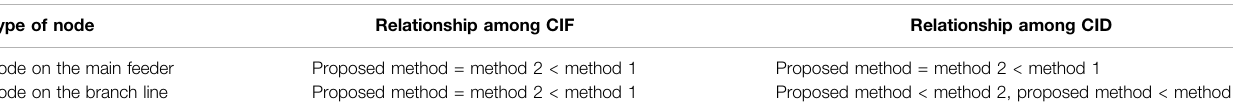
TABLE 8 | Relationships among nodal CIF/CID of the three methods.